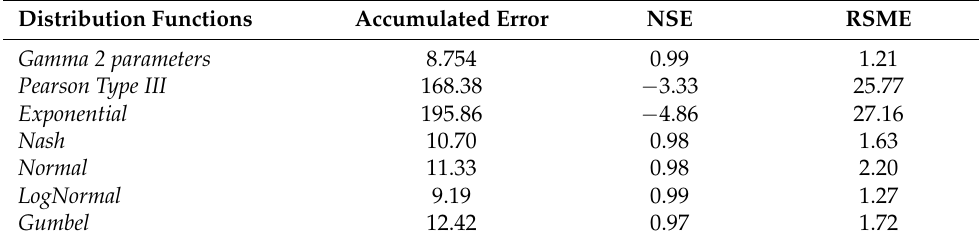
Table 2. Analyzed distribution functions and their adjustment statistics for the series of multiannual maximum precipitation in 24